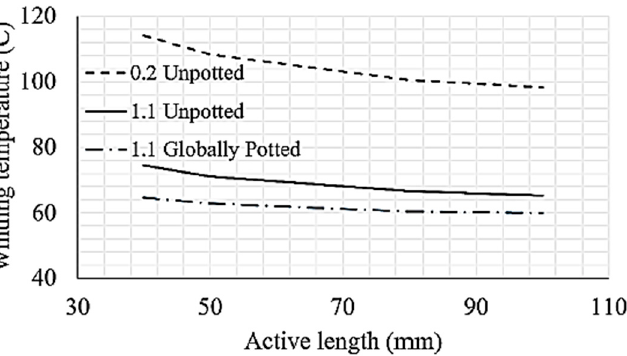
Figure 32. Stator potting effectiveness of conductive heat transfer from end winding [57].